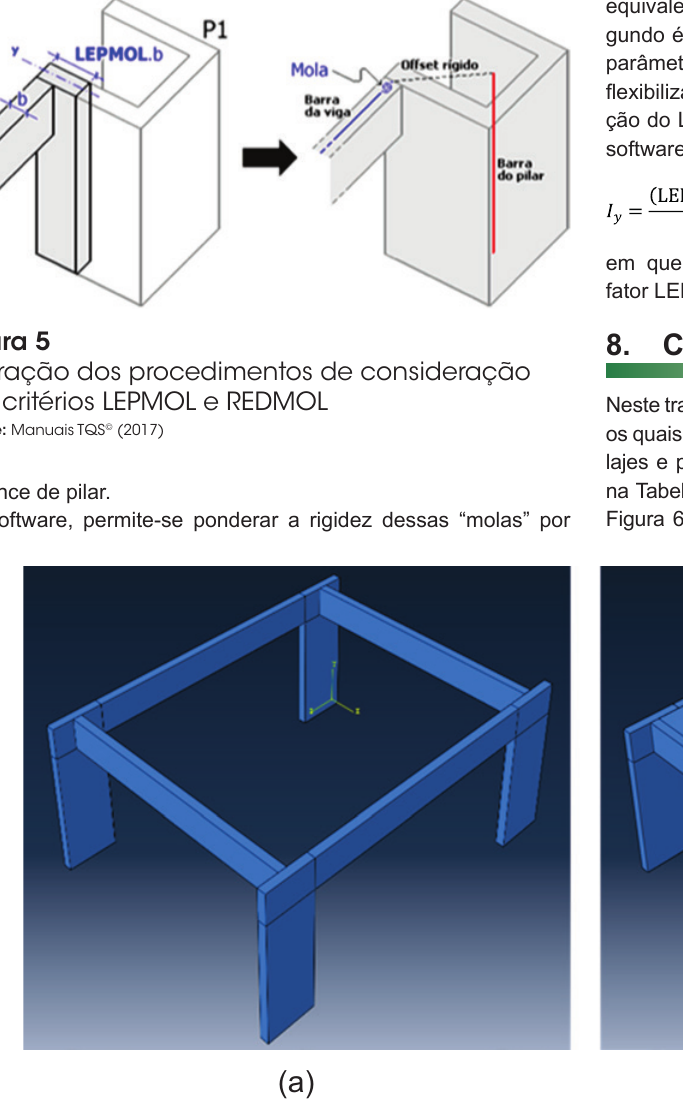
Apresentação dos modelos: (a) estrutura base para composição dos modelos sem lajes e (b) estrutura base para composição dos modelos com